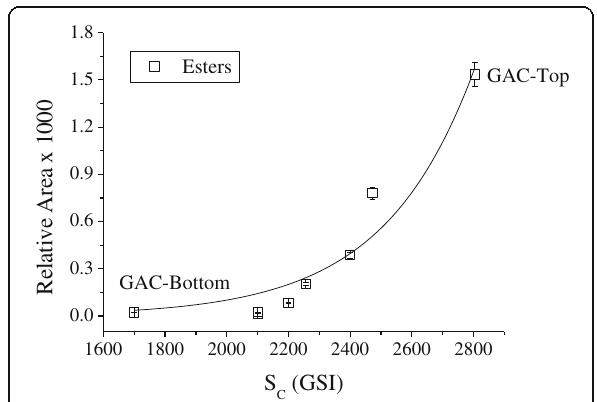
Fig. 13 Relation between Sc and the relative area under the TD-GC/ MS chromatographic signal for esters